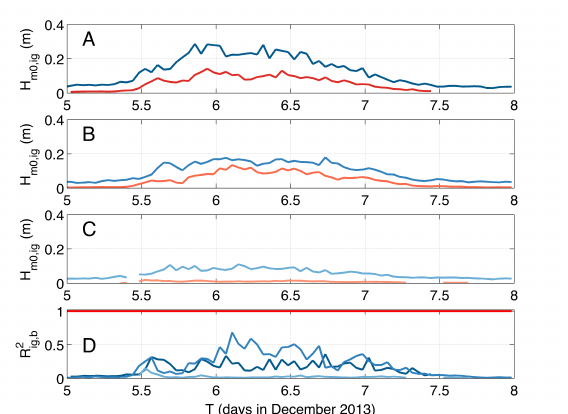
Figure 4. IG conditions during storm Xaver at locations A12 (dark blue), Q1 (blue) and EUR (light blue). ( A ) Bound (red) and total (blue) IG wave height at A12. ( B ) Bound (red) and total (blue) IG wave height at Q1. ( C ) Bound (red) and total (blue) IG wave height at EUR. ( D ) Ratio of the predicted bound IG variance over the observed IG variance where the red line corresponds to zero